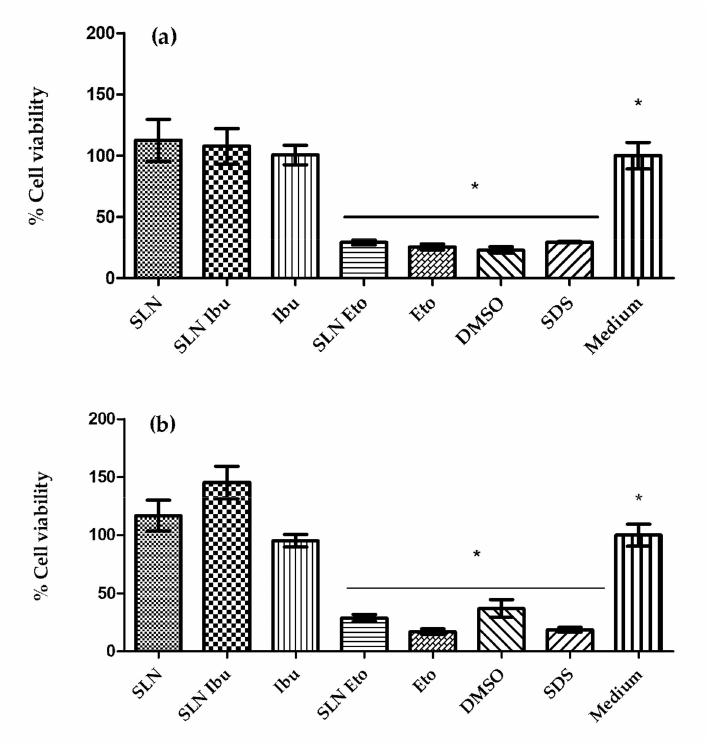
Figure 7. Cell viability (( a )-Df and ( b )-HaCaT cell lines) after 24 h of incubation with 10 µ L of empty SLNs (SLN), ibuprofen loaded-SLNs (SLN Ibu) (3 mg/mL), etofenamate loaded-SLNs (SLN Eto) (6 mg/mL), etofenamate solubilized in DMSO (Eto) (1.2 mg/mL), ibuprofen solubilized in DMSO (Ibu) (3 mg/mL), DMSO (dimethyl sulfoxide), SDS (sodium lauryl sulfate) (10 mg/mL), and cell culture medium (Medium). Results represent the mean ± S.D., n = 9; * p < 0.05 vs medium. The internalization of fluorochrome-labeled SLNs (Nile red) was studied in HaCaT cells and evaluated by fluorescence microscopy (Figure